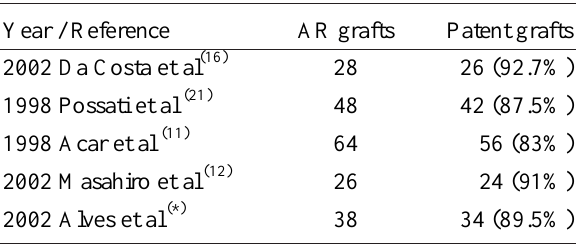
Table 3. Review of the literature about the late patency rate of the radial